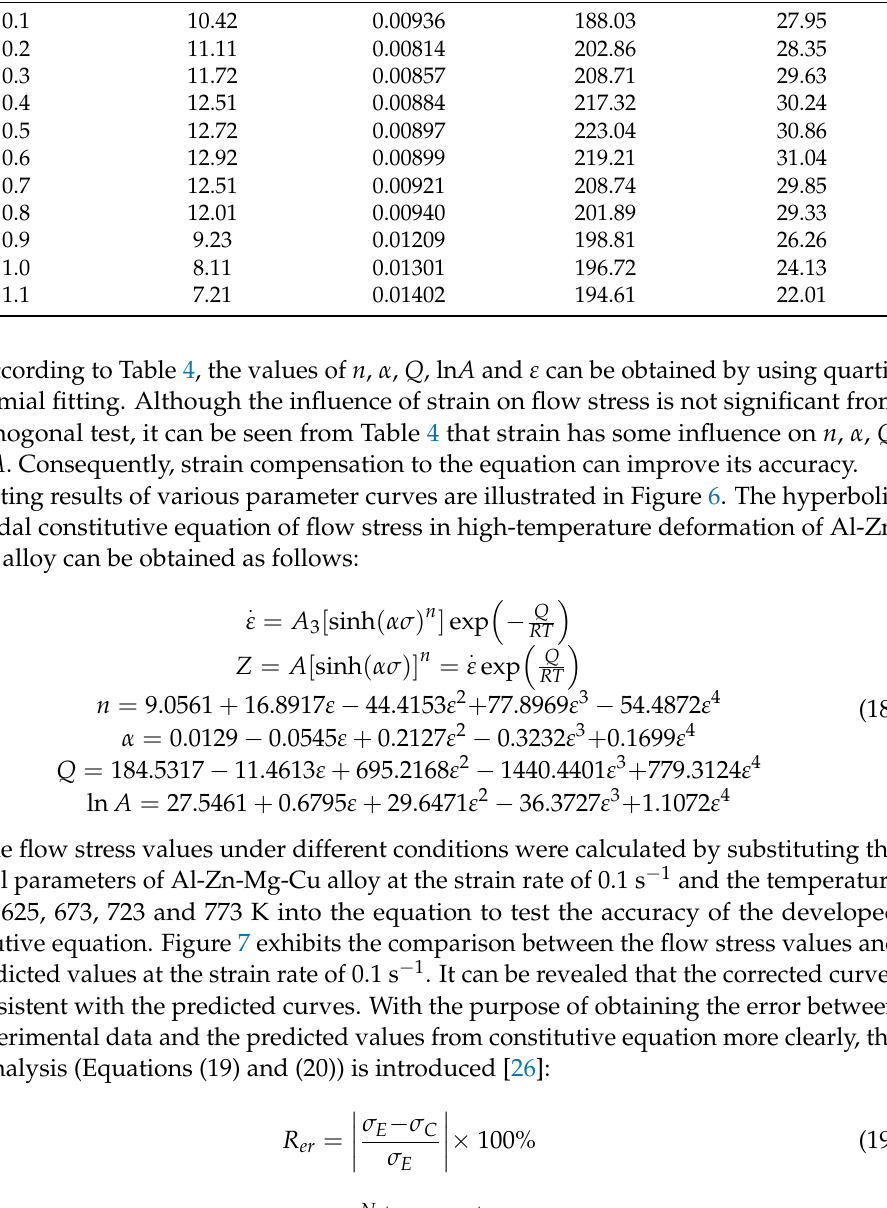
Table 4. Equation parameters corresponding to different strains of Al-Zn-Mg-Cu alloy.